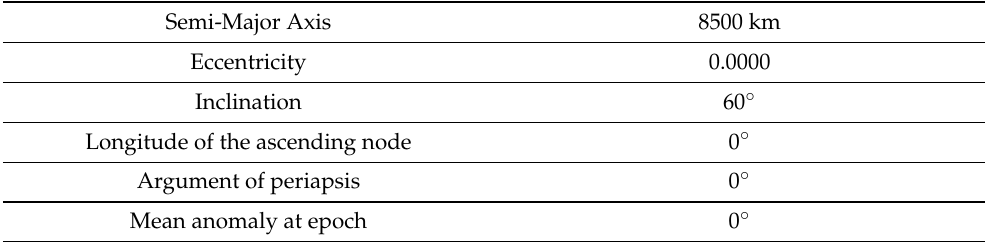
Table 2. The installation direction and turntable rotation half-angle of each ISL terminal. Azimuth Elevation Half-Angle ISL Terminal I 0 ◦ 0 ◦ 89 ◦ ISL Terminal II 180 ◦ 0 ◦ 89 ◦ ISL Terminal III − 90 ◦ 0 ◦ 89 ◦ ISL Terminal IV 90 ◦ 0 ◦ 89